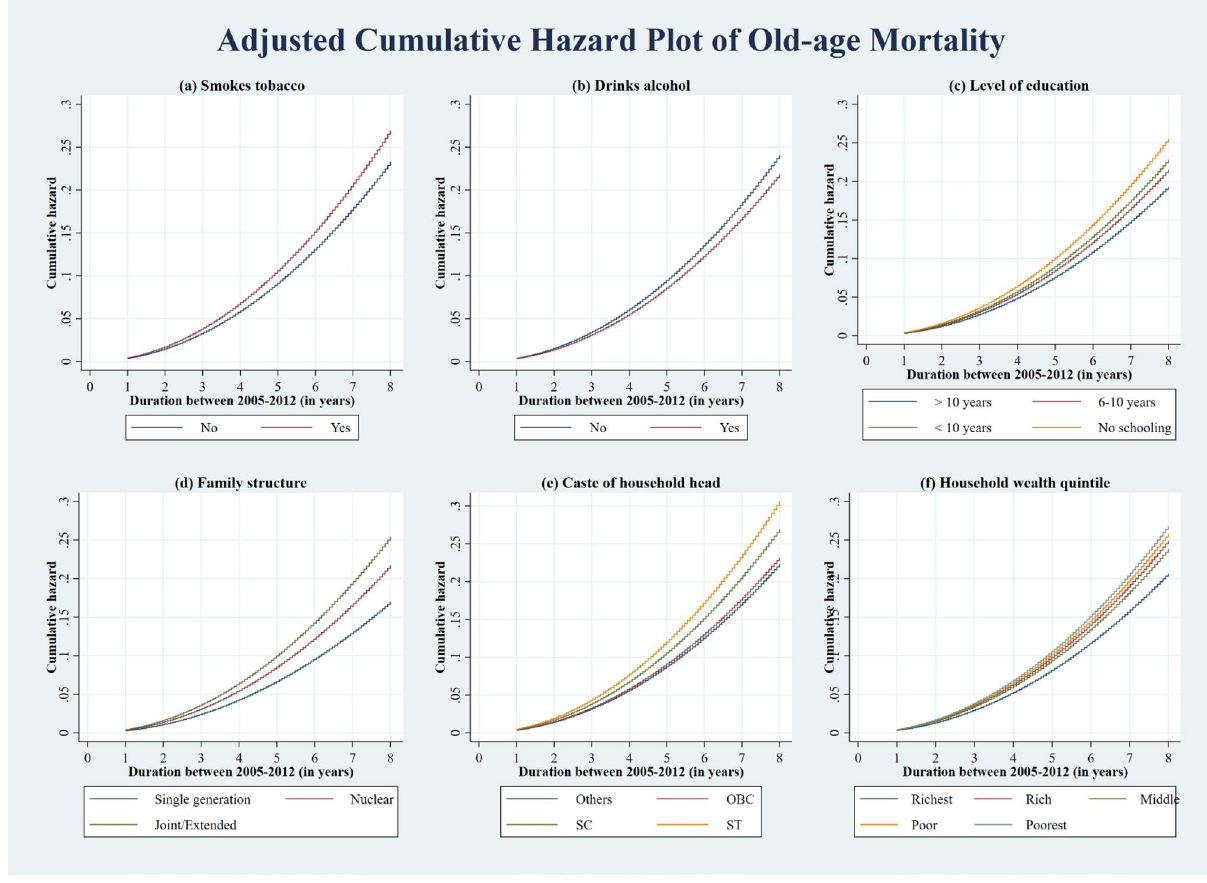
Figure 3. Adjusted Cumulative Hazard plot of old-age mortality by lifestyle, social and economic characteristics in India between 2005 and